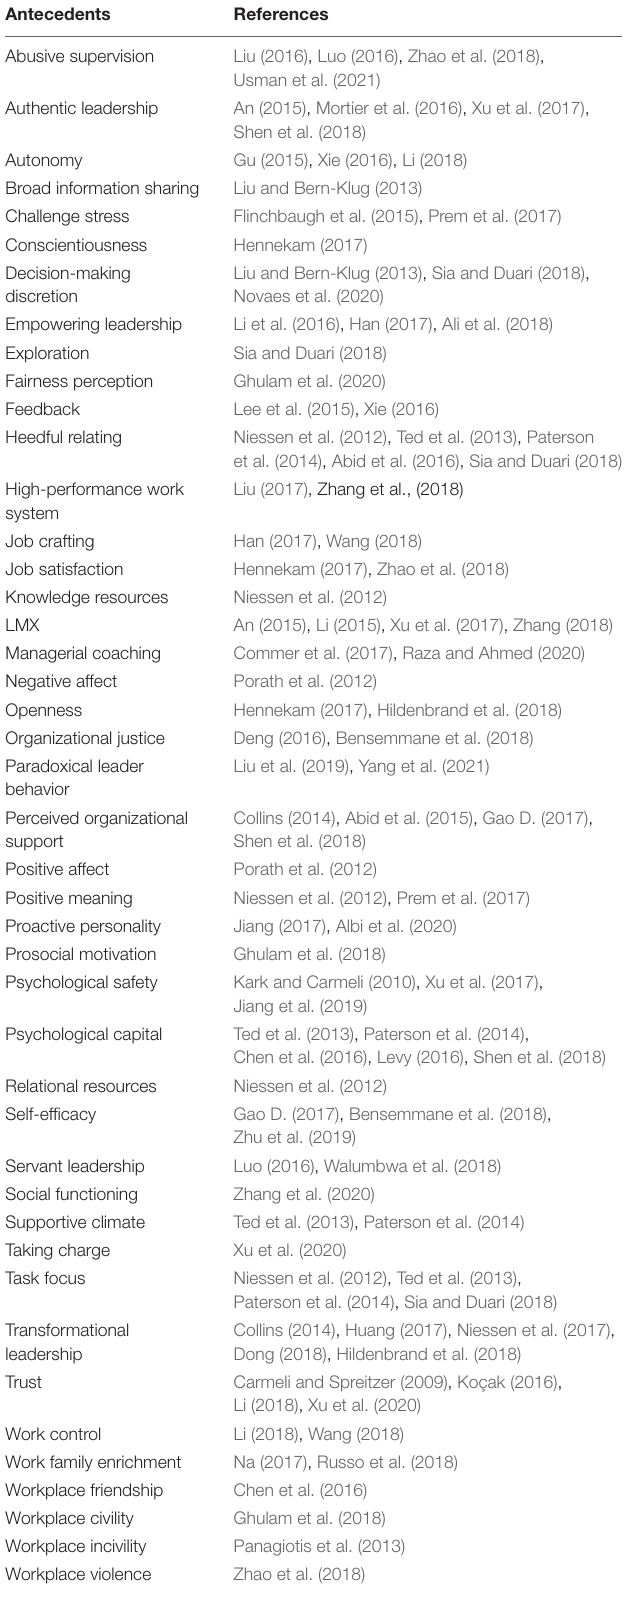
TABLE 1 | Summary of the antecedents of thriving at